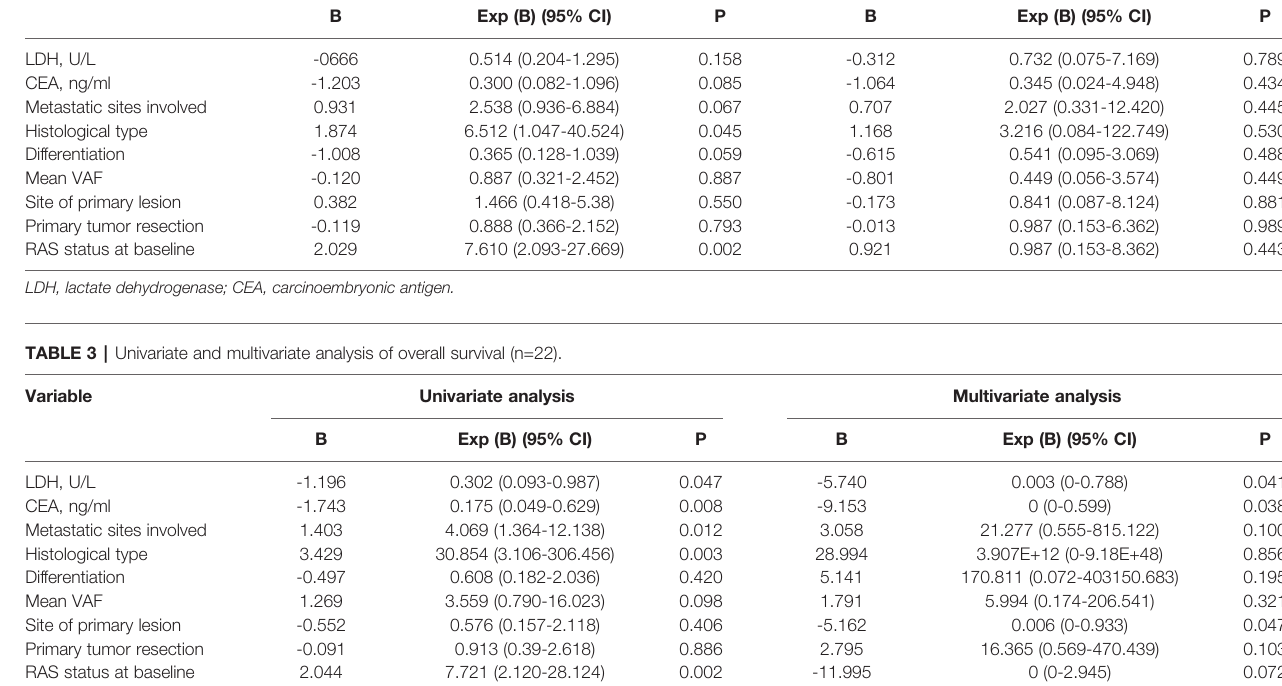
TABLE 2 | Univariate and multivariate analysis of progression free survival (n=22). Variable